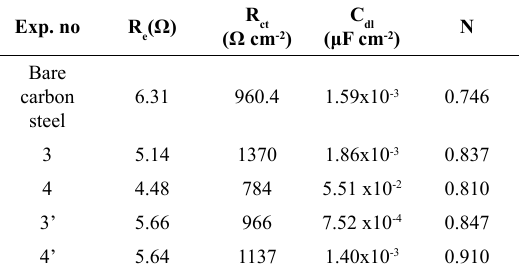
and C values obtained by simulating the EIS data Table 4. R ct dl ( Figure 6 ) using the equivalent circuits presented in Figure 7 Exp. no